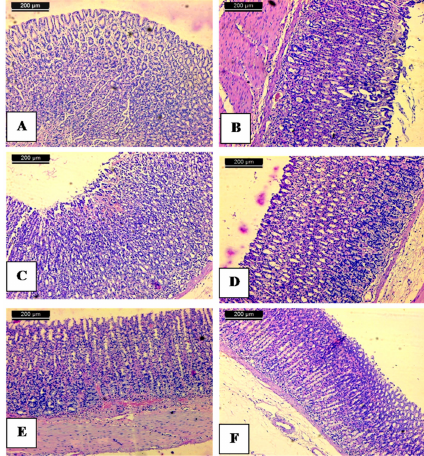
Figure 3. Anti-ulcer activity of 70% alcoholic extract of above ground of C. conglomerates; ( A ) normal control showing stomach mucosa with intact surface mucosal epithelium and no lesion appeared; ( B ) stomach mucosa of an ulcer group showing severe disruption of the surface epithelium and necrotic lesions mucosa with inflammatory cells infiltration and hemorrhage as well; ( C ) stomach mucosa of rat treated with 25 mg / kg. b.w of 70% alcoholic C. conglomeratus extract showing mild mucosal surface erosion mild disruption to the surface epithelium mucosa with no edema and no leucocytes infiltration of the submucosal layer; ( D ) stomach mucosa of treated with 50 mg / kg. b.w of 70% alcoholic C. conglomeratus extract showing mild erosion; ( E ) mucosa of group treated with 100 mg / kg. b.w of 70% alcoholic C. conglomeratus extract shows intact surface mucosal epithelium and no lesion appeared; ( F ) mucosa of group treated with Ranitidine showing mild erosion of mucosa. The scale bar length is 200 µ